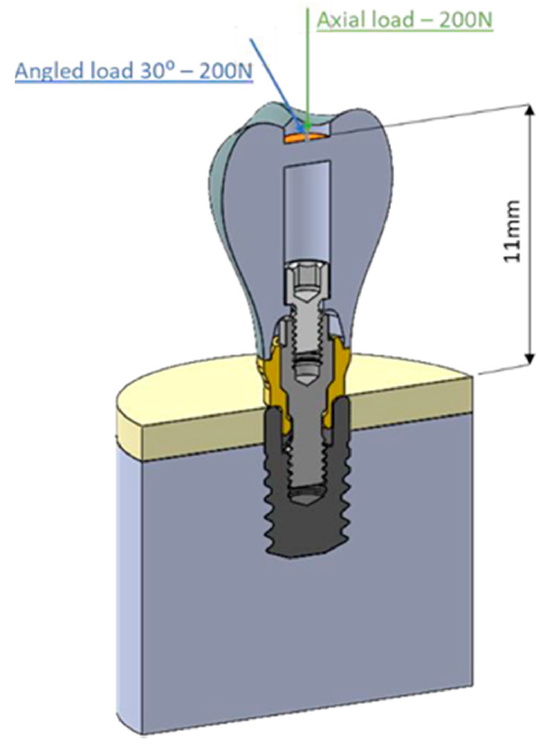
Figure 3. In orange, load application area. In green, the axial load of 200N, in blue, an angled load at 30° of 200N.